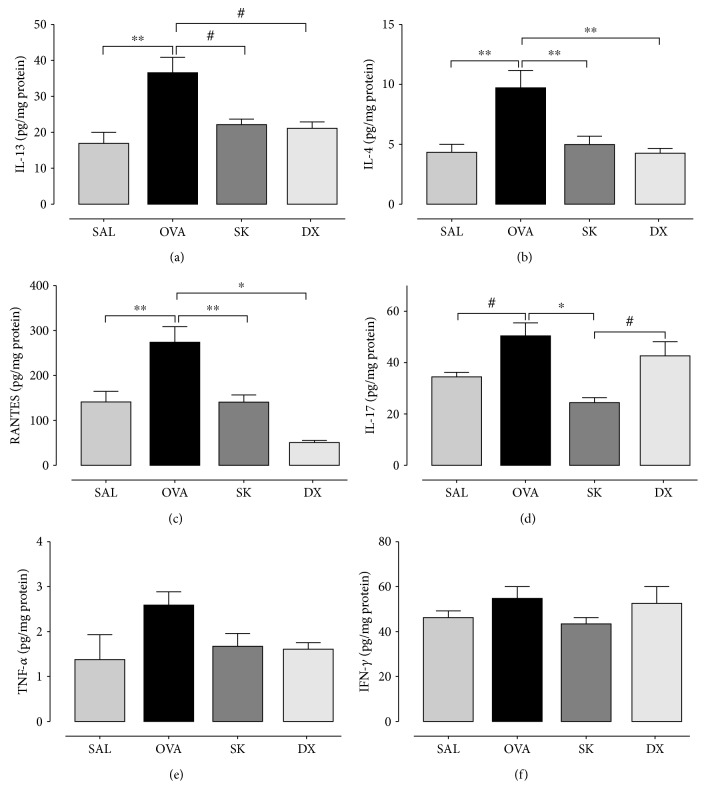
Sakuranetin inhibits Th2 and Th17 cytokines in lung content (pg/mg) that was increased in the OVA group: (a) IL-13; (b) IL-4; (c) RANTES; (d) IL-17; (e) TNF-α; (f) IFN-γ measured by ELISA technique in lung homogenate. ∗p < 0.001, ∗∗p < 0.01, and #p < 0.05. Data represents mean ± SEM from 6 to 9 mice per group.